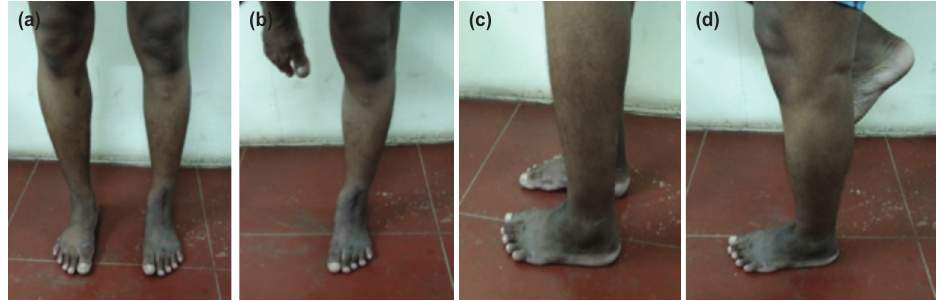
(a, b, c, d) Clinical pictures of Patient 4 at 12 months of Fig. 5: